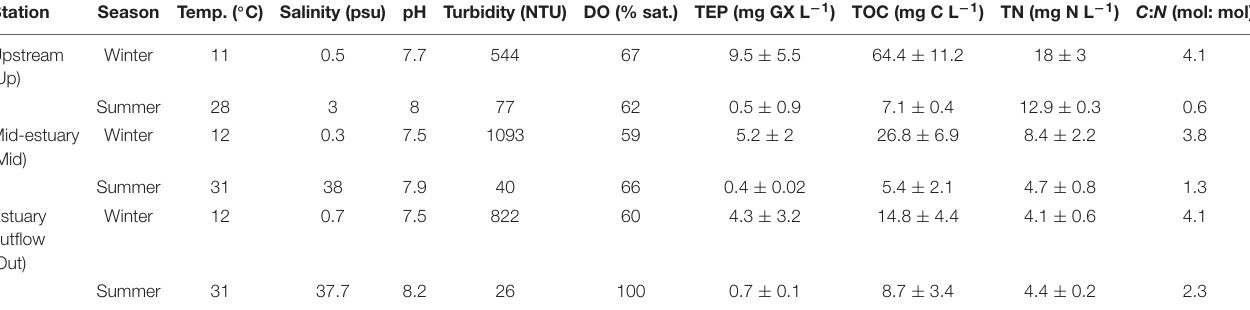
TABLE 1 | Spatiotemporal physicochemical properties of surface water from three sites along the Qishon River. Station